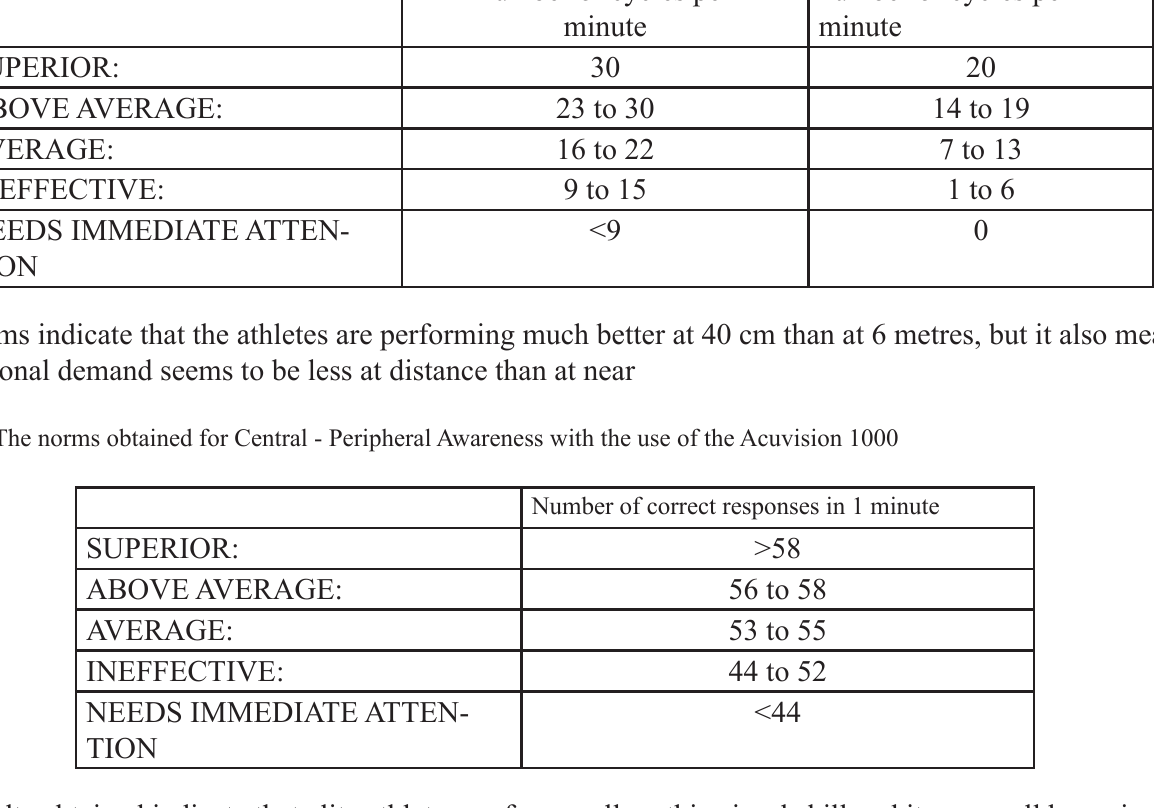
Pro-action Re-action number of correct responses in number of correct 1 minute